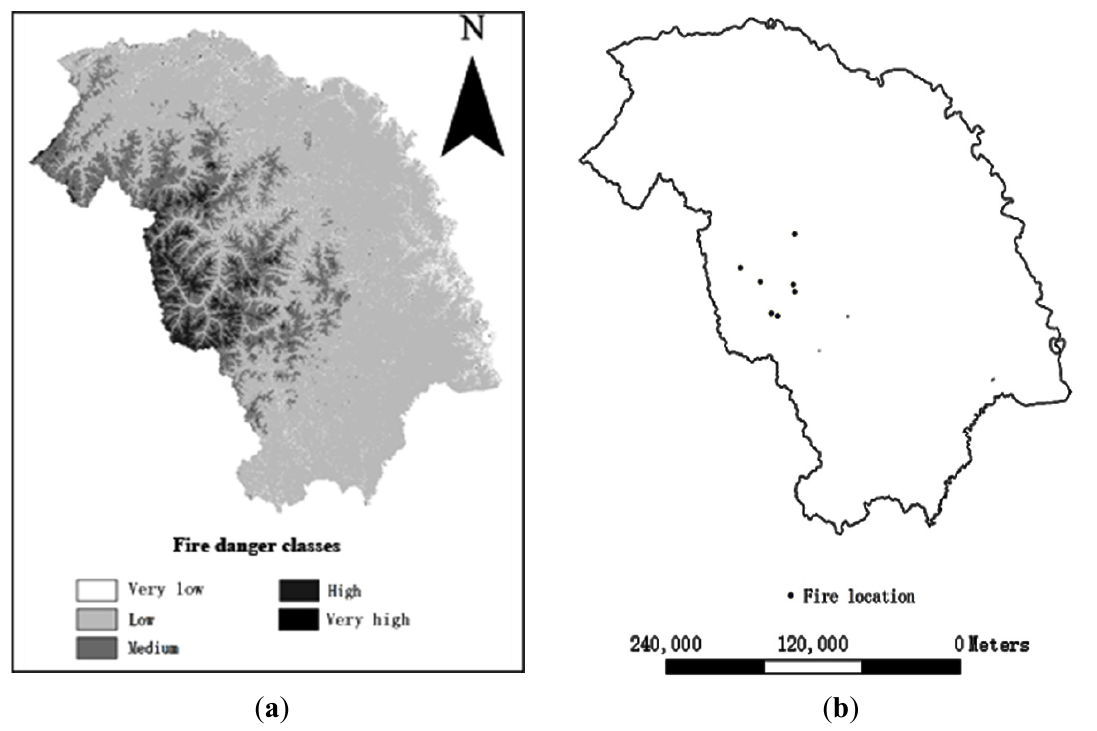
Figure 4. Comparison between the modelled fire danger rating and observed fire occurrence on September 26, 2010. The predicted model performed well in terms of accuracy relative to a random model (AUC = 0.5), with a mean AUC and maximum kappa values of 0.866 and 0.782 respectively. The Maxent model is adequate for predicting lightning fire occurrence in this